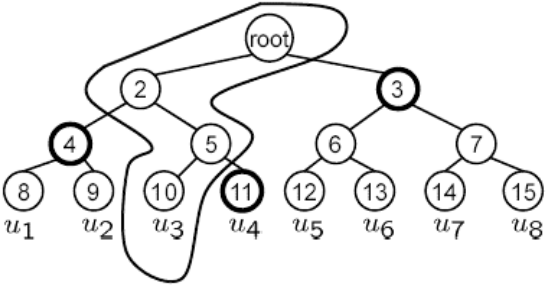
Figure 1. KUNode Algorithm Example